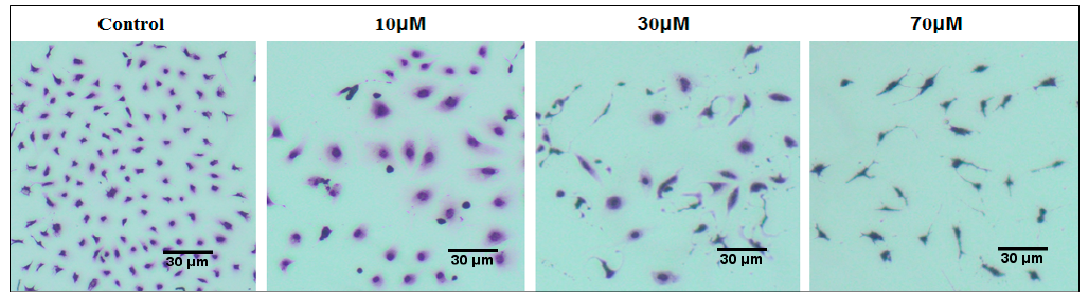
Figure 4. Morphology of SKOV-3 cells before and after exposure to curcuminoids at different concentrations for 24 h. Cells were stained with Giemsa dye and imaged using bright field microscopy.